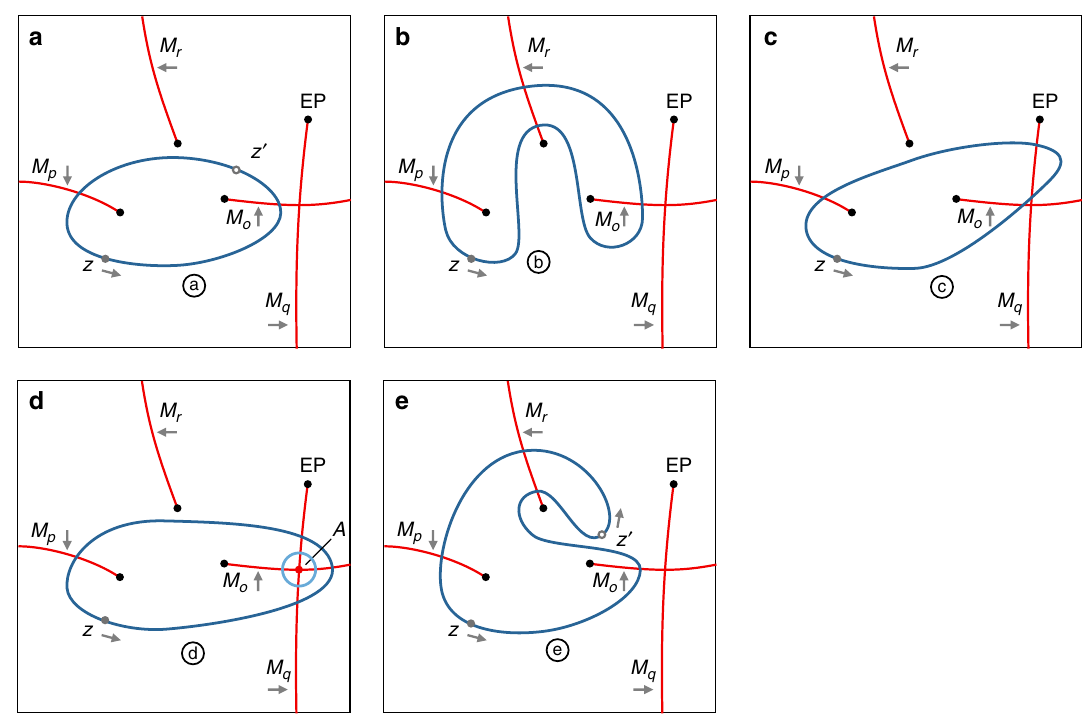
Fig. 3 Homotopy between loops. Illustration of equivalence between homotopic loops in the parameter space of a generic Hamiltonian. a Loop a encloses two exceptional points (EPs) associated with matrices M o and M p . b Loop ⓑ encloses the same two EPs yet it cannot be deformed into loop ⓐ without crossing EP associated with M r . Consequently, it has a different matrix product (assuming not accidental equivalence). On the other hand, loops ⓒ and ⓓ in c and d can be deformed into loop ⓐ without crossing any EP. As a result, they are equivalent (have the same matrix product) as shown in the text. e A peculiar case of free homotopy is presented. Loop ⓔ is homotopic with loop ⓐ for the starting point z but not for z ′ . As a result, the two loops are equivalent for the former point but not for the latter. The discussion here is very generic and can be extended easily to any other con fi guration of EPs and branch cuts (BCs). As a side note, we emphasize that the choice of the BCs is not unique. However, while different partitioning will lead to a new set of matrices, the fi nal results and the topological relations between the loops are invariant. Black dots represent EPs, red lines are the BCs, and the blue loops are